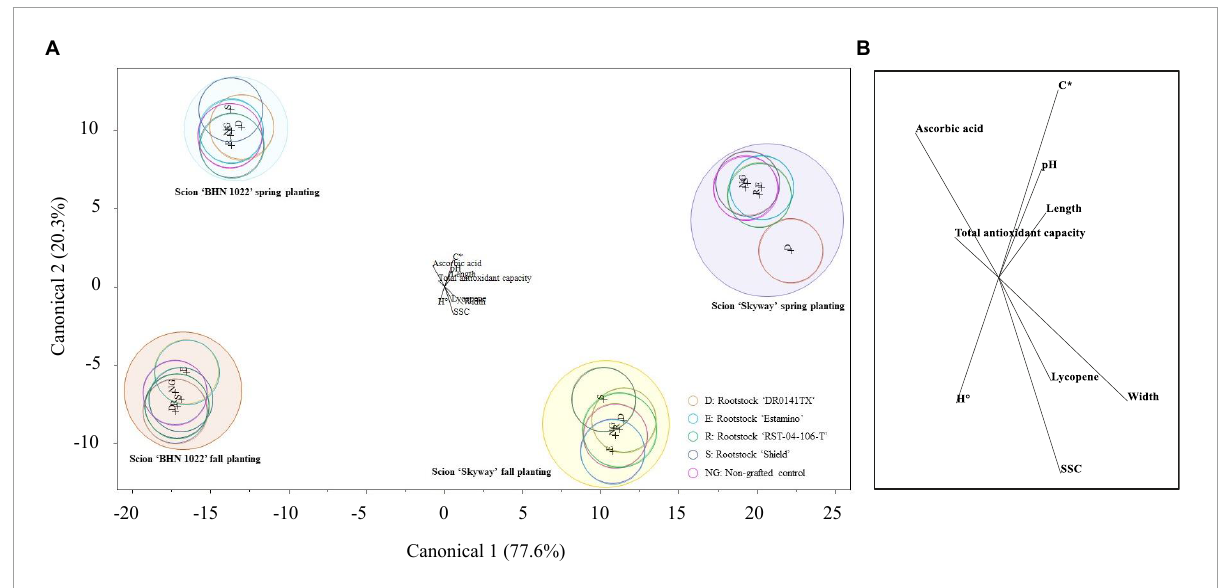
FIGURE3 Plot of the first and second canonical functions of canonical discriminant analysis with the forward stepwise variable selection method based on p ≤ 0.05 for different planting season-scion-rootstock treatments using tomato fruit physical and chemical attributes. The circle represents the 95% confidence interval. (A) Canonical plot. (B) Fruit quality parameters contributing to treatment